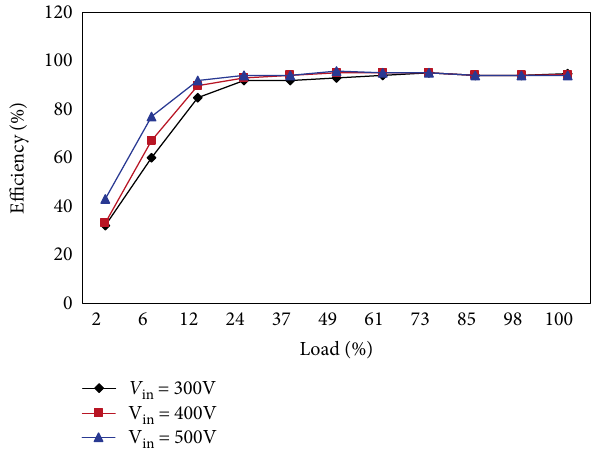
Figure 18: Output voltage and output current waveforms when the load is abrupt. (a) 0–80% load mutation and (b) 80–0% load mutation.